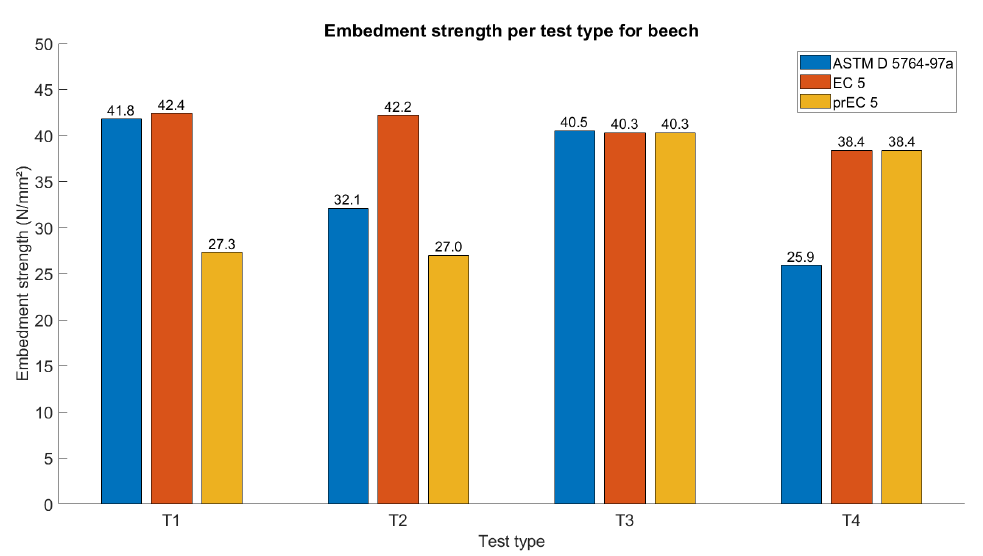
Figure 11. Comparison between experimental and theoretical values of embedment strength per test type for poplar.